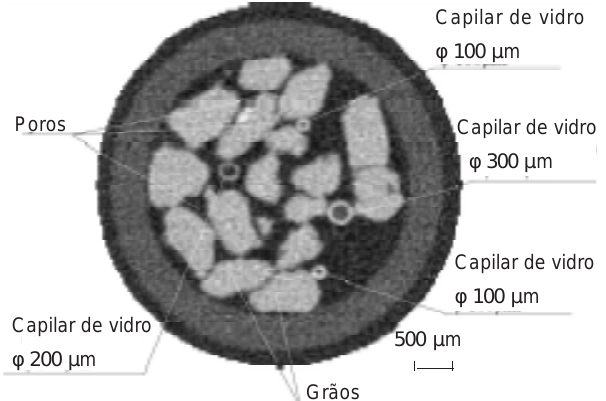
Figura 4. Tomografia de uma amostra de grãos de areia de aproximadamente 1 mm, capilares de vidro, sendo dois de 100, um de 200 e um de 300 mmmmm m.